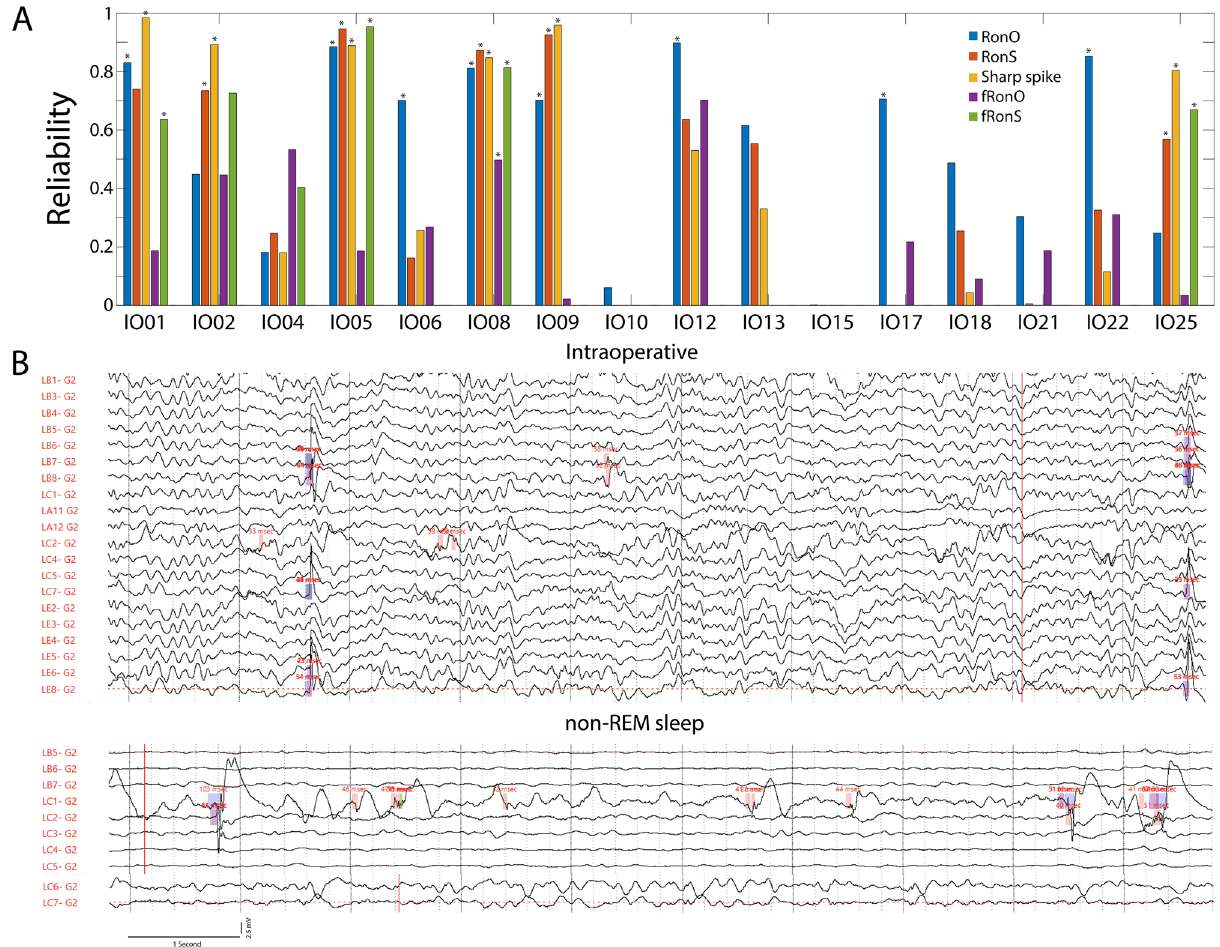
Figure 4. Evaluation of reliability in the spatial distribution of HFOs and sharp-spikes during the intraoperative and non-REM sleep recordings from matched electrode contacts. ( A ) The reliability measure computed from the scalar product for all pairs of HFO vectors between the two conditions for the 16 patients. Asterisk indicates significant reliability ( p < 0.05) with respect to a random distribution (n = 2000 surrogates). ( B ) Intraoperative recording from patient IO015 shows RonS (pink and blue) in lateral temporal contacts (LB7,8,LC7), but during non-REM sleep recordings RonS, RonOs (pink), and fRonOs (green) appeared on in a mesial temporal contact (LC1), which was part of the